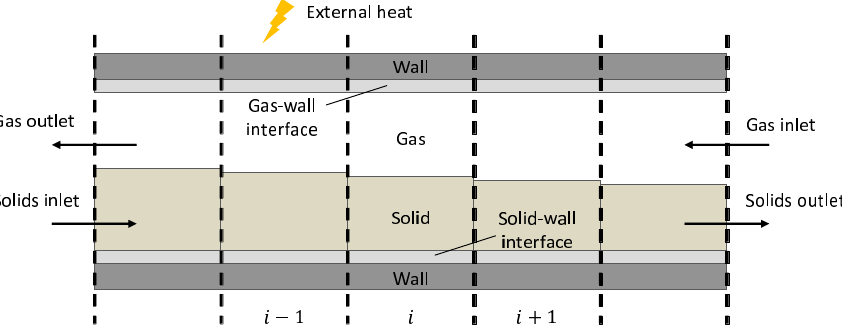
Figure 7. Structure of a multi-compartment rotary kiln model describing a counter–current calcination process. Three different phases are considered: gas, solid and wall. The system is externally heated via the kiln